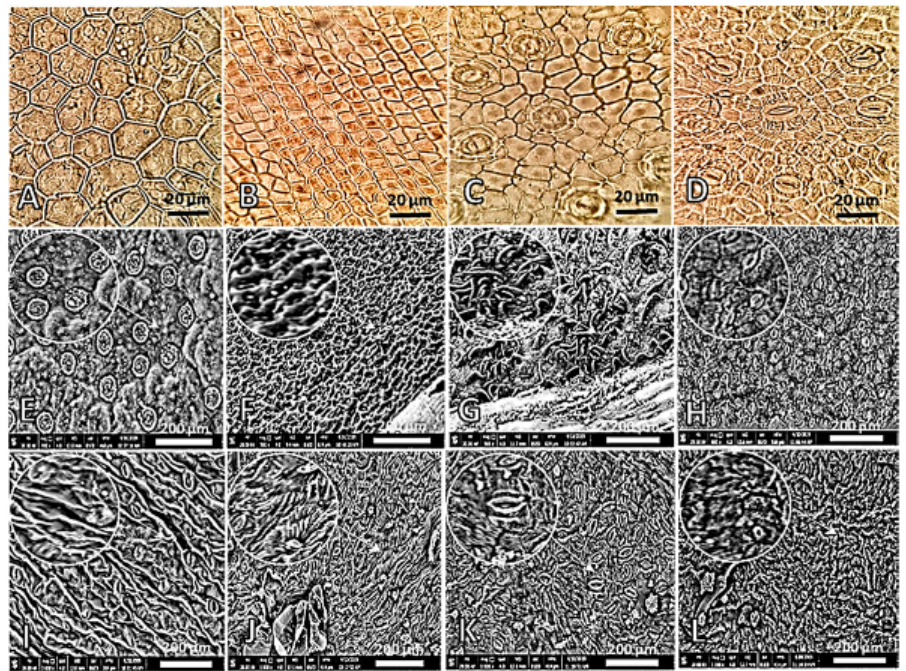
Figure 1. Di ff erent shapes of the epidermal cells of various studied Apocynaceae leaves investigated by light microscope ( A – D , 140 × ) and scanning electron microscope (SEM) ( E – L ). ( A , H ): A. curassavica , ( B , K ): C. carandas , ( C , F ): D. boliviensis , ( D , I ): C. procera , ( E ): A. obesum , ( G ): N. oleander , ( J ): A. oblongifolia , and ( L ): T. neriifolia